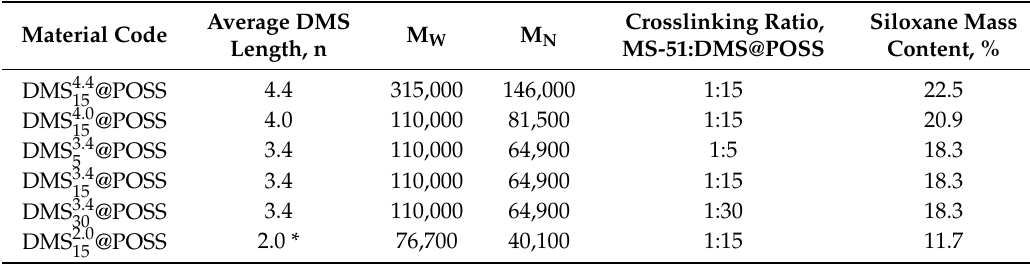
Table 1. Summary of the materials composition and the properties used to fabricate gas separation membranes.